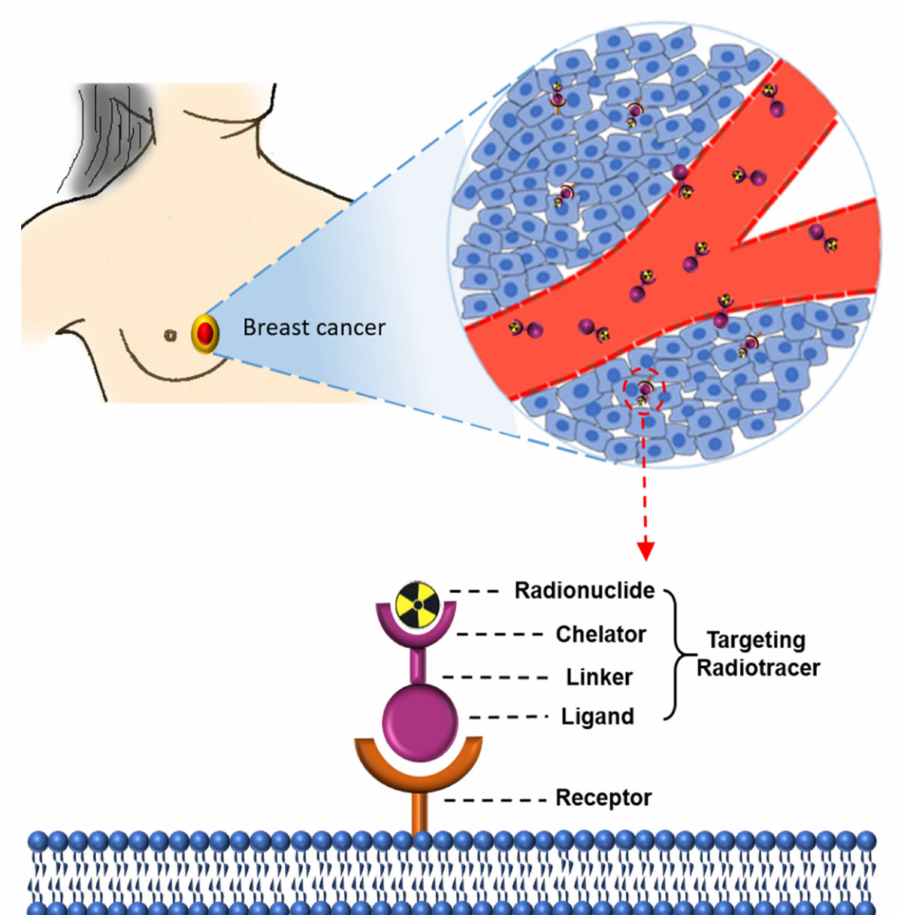
Figure 1. Schematic overview of receptor-targeting molecular imaging for breast cancer. The molec- ular probes consist of a ligand, linker, chelator, and radionuclide. Ligands that bind to the overex- pressed receptors on breast cancer cells can be coupled to a chelator often through a linker. Chelators enable the labeling of ligands with radionuclides such as 68 Ga and 99m Tc, which are combined through a